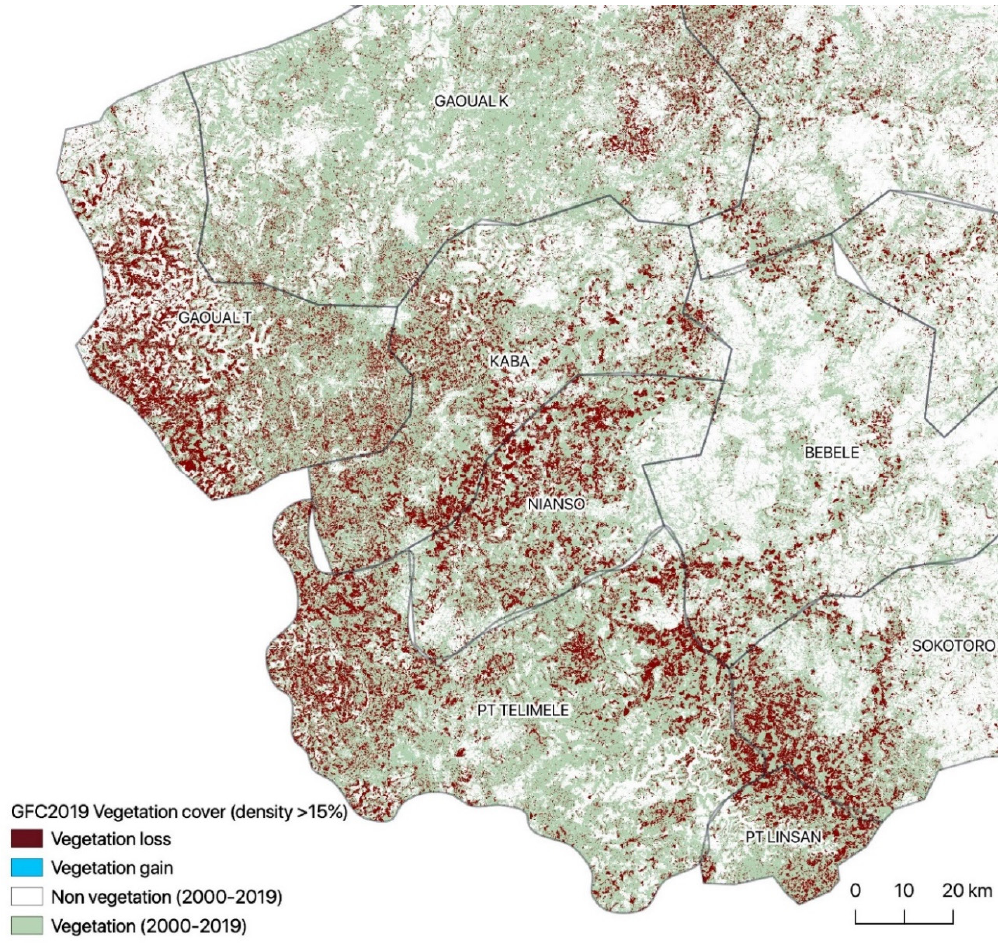
Figure 8. Vegetation (density higher than 15%) in 2000 and 2019 and vegetation losses and gains (2001-2019) (GFC product, [29]) for the western basins of the FD, where vegetation losses are the highest. The area represented is the one of the empty brown square in Figure